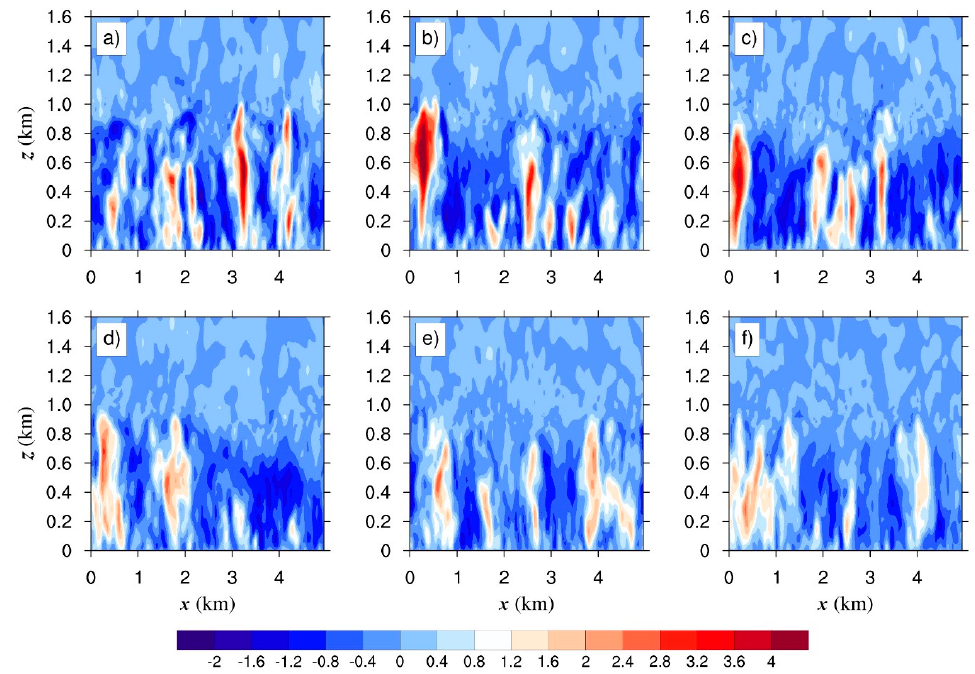
Figure 4. X – z cross-sections of the vertical velocity averaged over 200 time-steps (about 6–7 min) for the cases of ( a ) CTL, AOD = 0; ( b ) A03, AOD = 0.3; ( c ) A06, AOD = 0.6; ( d ) A09, AOD = 0.9; ( e ) A12, AOD = 1.2; and ( f ) A15, AOD = 1.5 with the free-atmosphere potential temperature gradient of 6 K km − 1 .